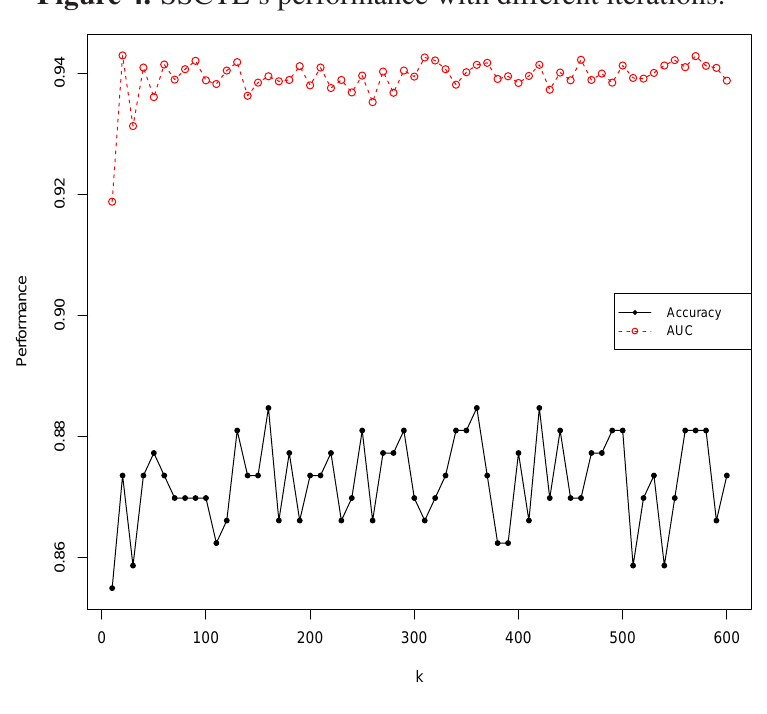
Figure 4. SSCTE’s performance with different iterations.